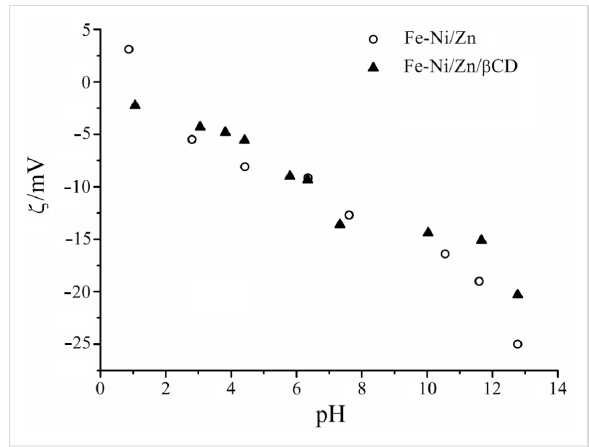
Figure 5: Zeta potential curves as a function of pH for the ( ○ ) Fe-Ni/Zn and ( ▲ ) Fe-Ni/Zn/ β